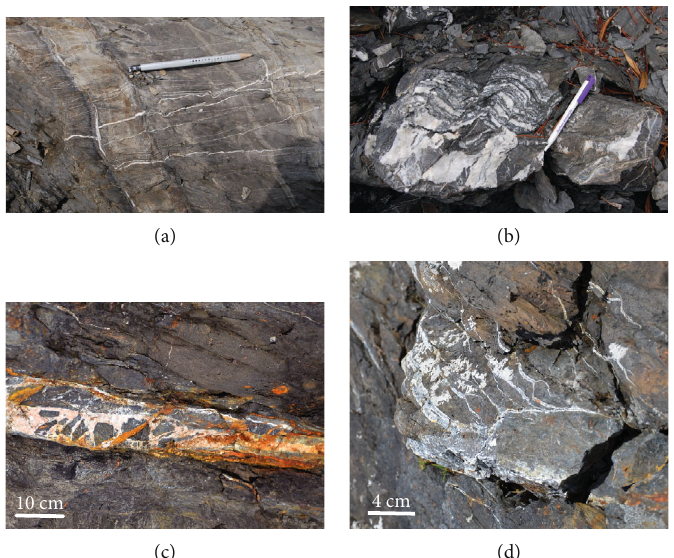
Figure 1: Examples of veins that may represent high fl uid pressures in rocks. (a) Veins containing layer-parallel and perpendicular branches (Sestri Liguria, Italy). (b) Layer-parallel “ beef ” -type veins (Sestri Liguria, Italy). (c) Large vein with brecciated host rock (Isle of Kerrera, Scotland, UK). (d) Tree-like branching vein (Isle of Kerrera, Scotland,